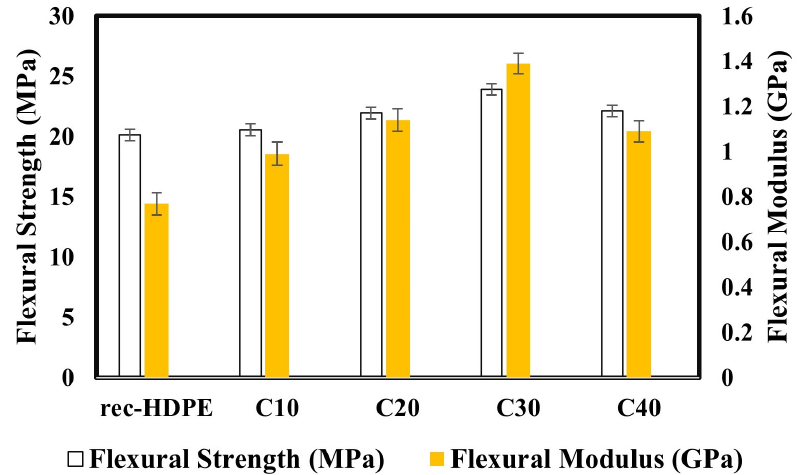
Figure 4. Flexural properties of the recycled HDPE and